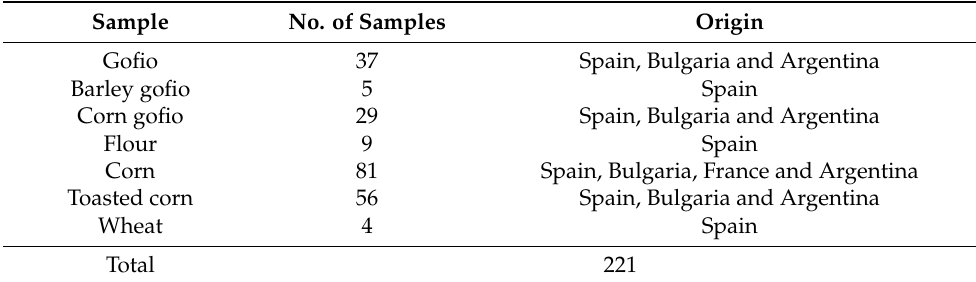
Table 1. Characteristics of the analyzed